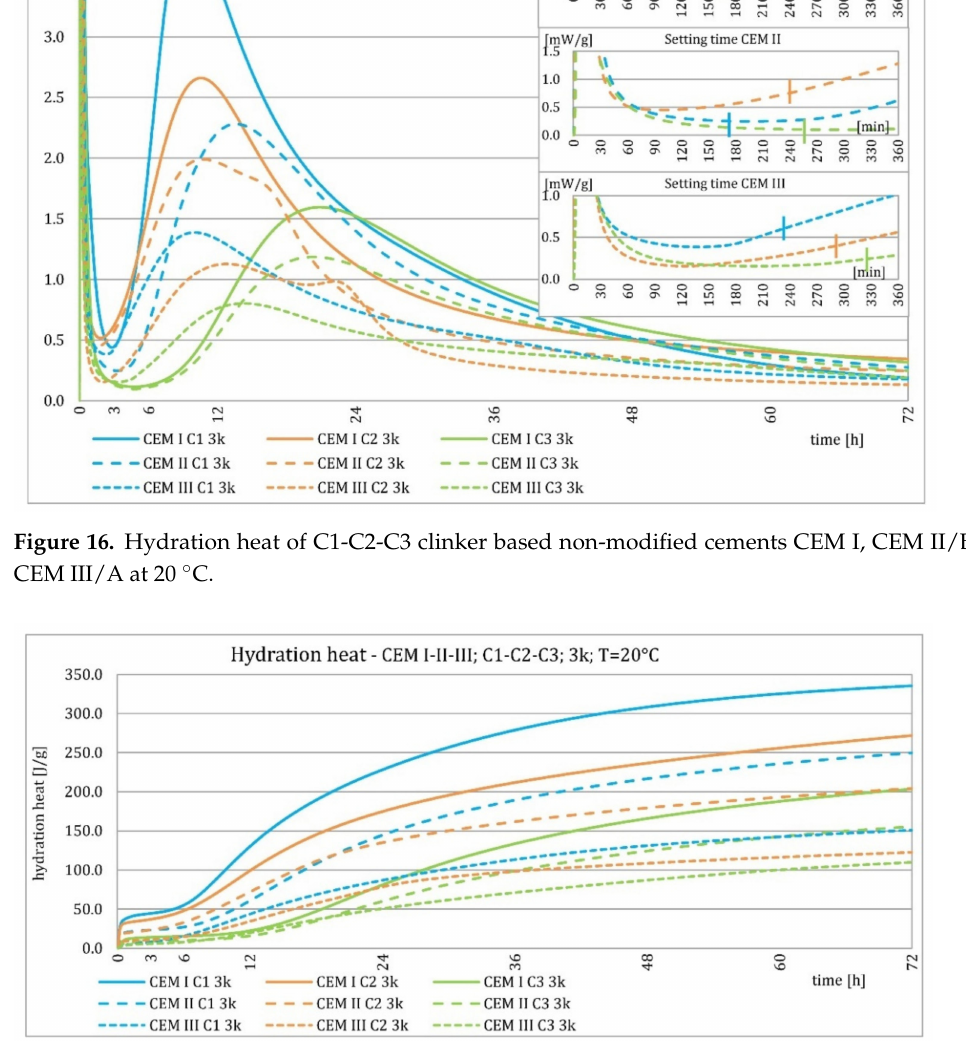
Figure 17. Hydration heat of C1-C2-C3 clinker based non-modified cements CEM I, CEM II/B-S, CEM III/A at 20 ◦